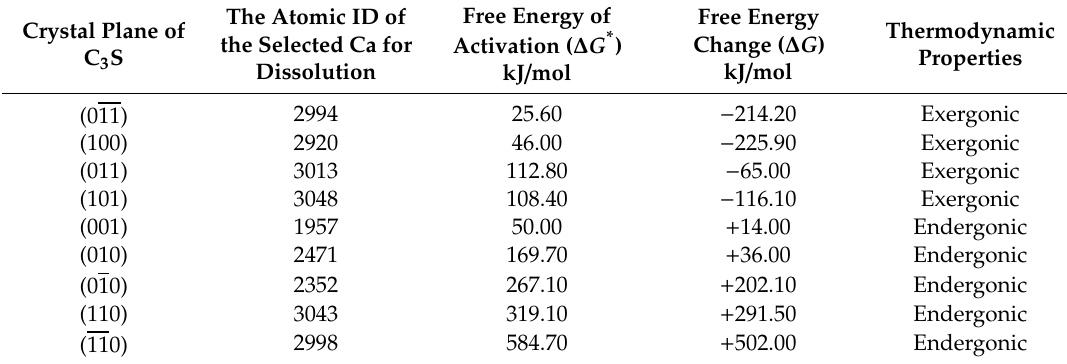
Table 1. Free energy change of di ff erent surfaces of C 3 S during the dissolution of calcium. Crystal Plane